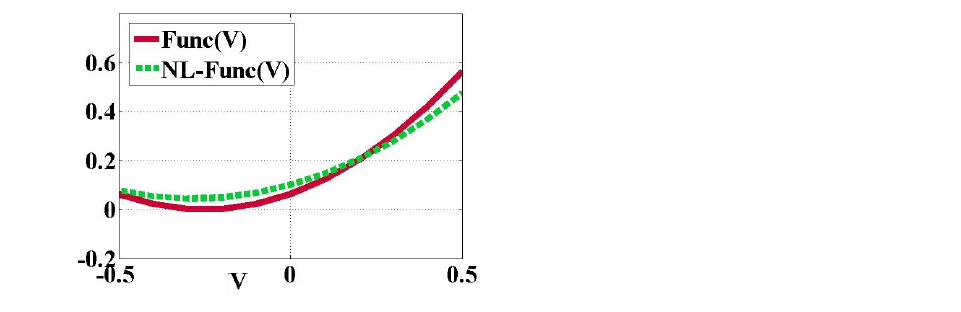
Figure 2. Approximation for the nonlinear function ( NL - Func ( V ) ) by the hyperbolic function ( Func ( V )